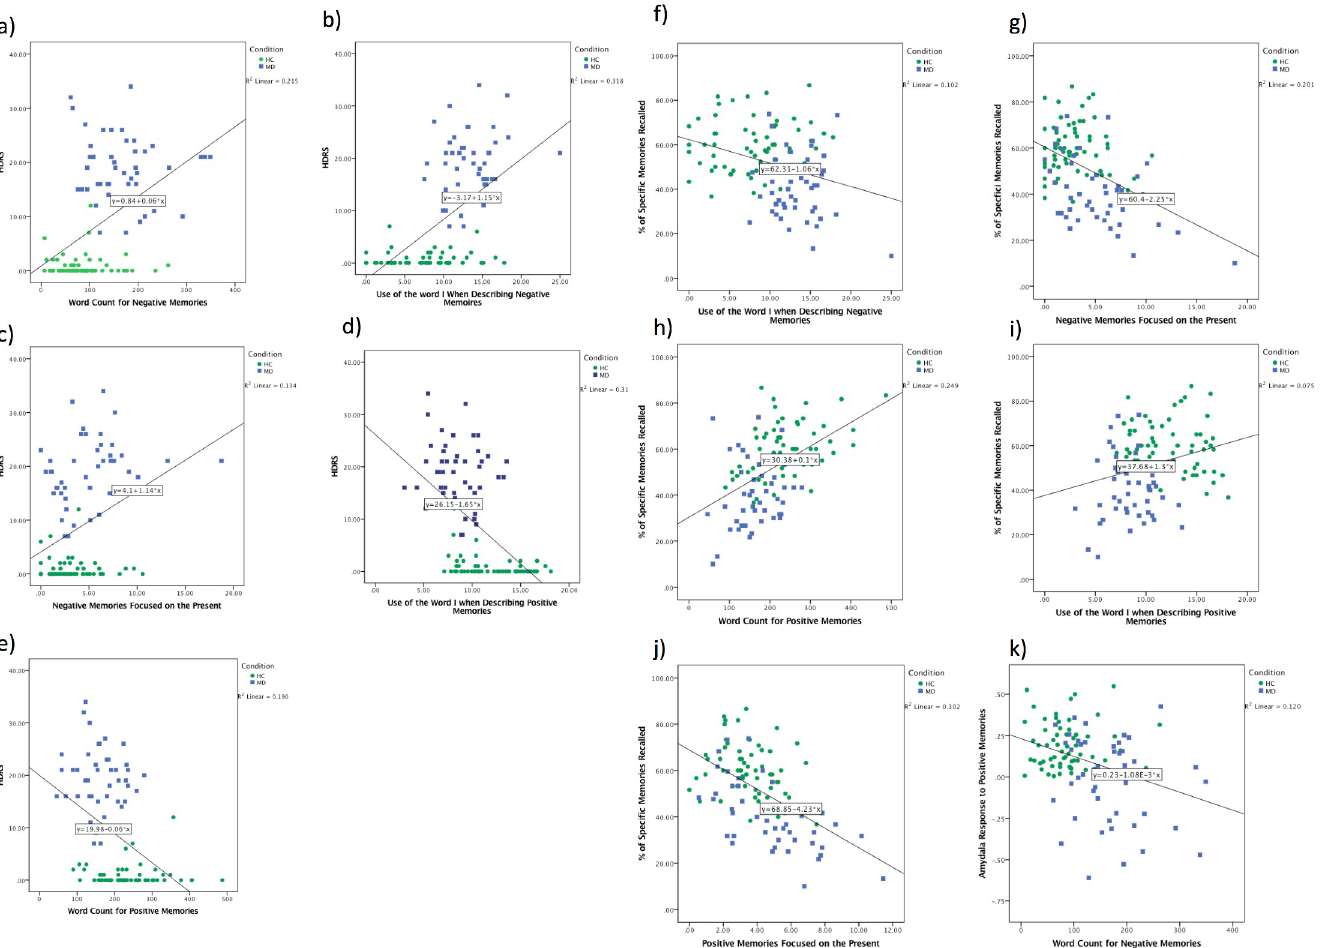
Fig 1. Correlation between linguistic and clinical/memory variables. (A-E) Correlation between depression severity as measured by the Hamilton Depression Ratings Scale (HDRS) and (A) word count for negative memories, B) use of “I” in negative memories, C) present focus for negative memories, D) use of “I” in positive memories and F) word count for positive memories. (F-J) Correlation between the percent of specific autobiographical memories recalled and (F) use of “I” in negative memories (G) present focus for negative memories, (H) word count for positive memories, (I) use of “I” in positive memories and (J) present focus for positive memories. (K) Correlation between the amygdala response to positive memories and word count for negative memories.